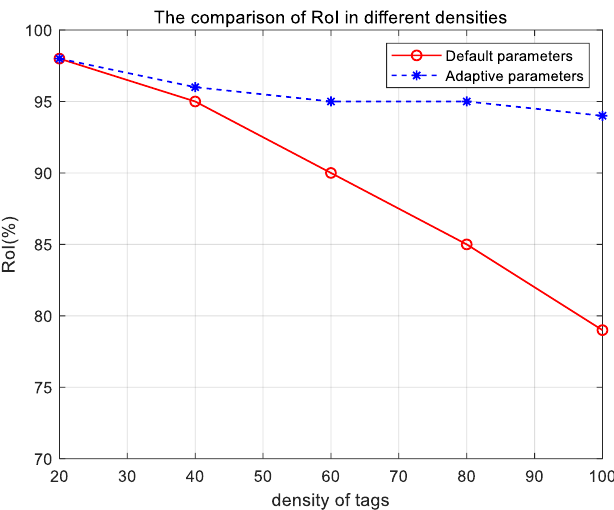
Figure 15. The RoI in different tag density.